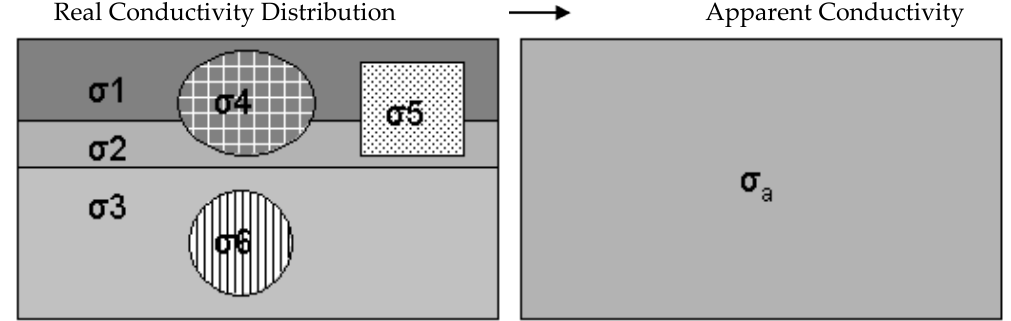
Figure 1. The concept of true and apparent conductivity [4]. σ 1 - σ 3 : The conductivity composed of several soil horizons / layers, σ 4 - σ 6 : liquid, solid-liquid, solid soil phases, and σ a : apparent conductivity.